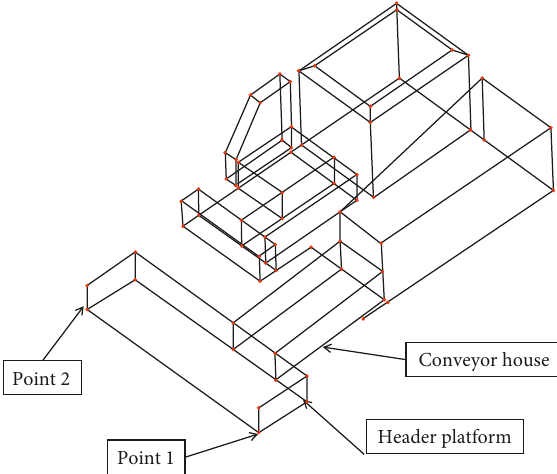
Figure 15: Two vibration test points on the front header.